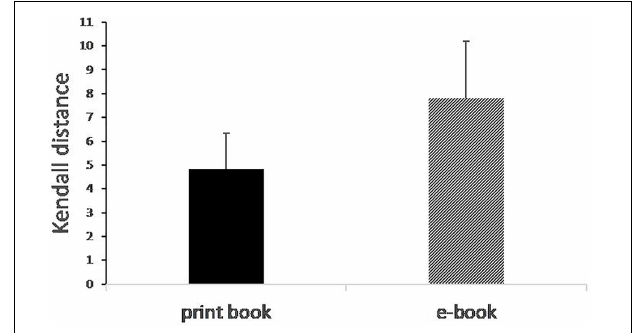
FIGURE 3 | Plot reconstruction task: distance from correct